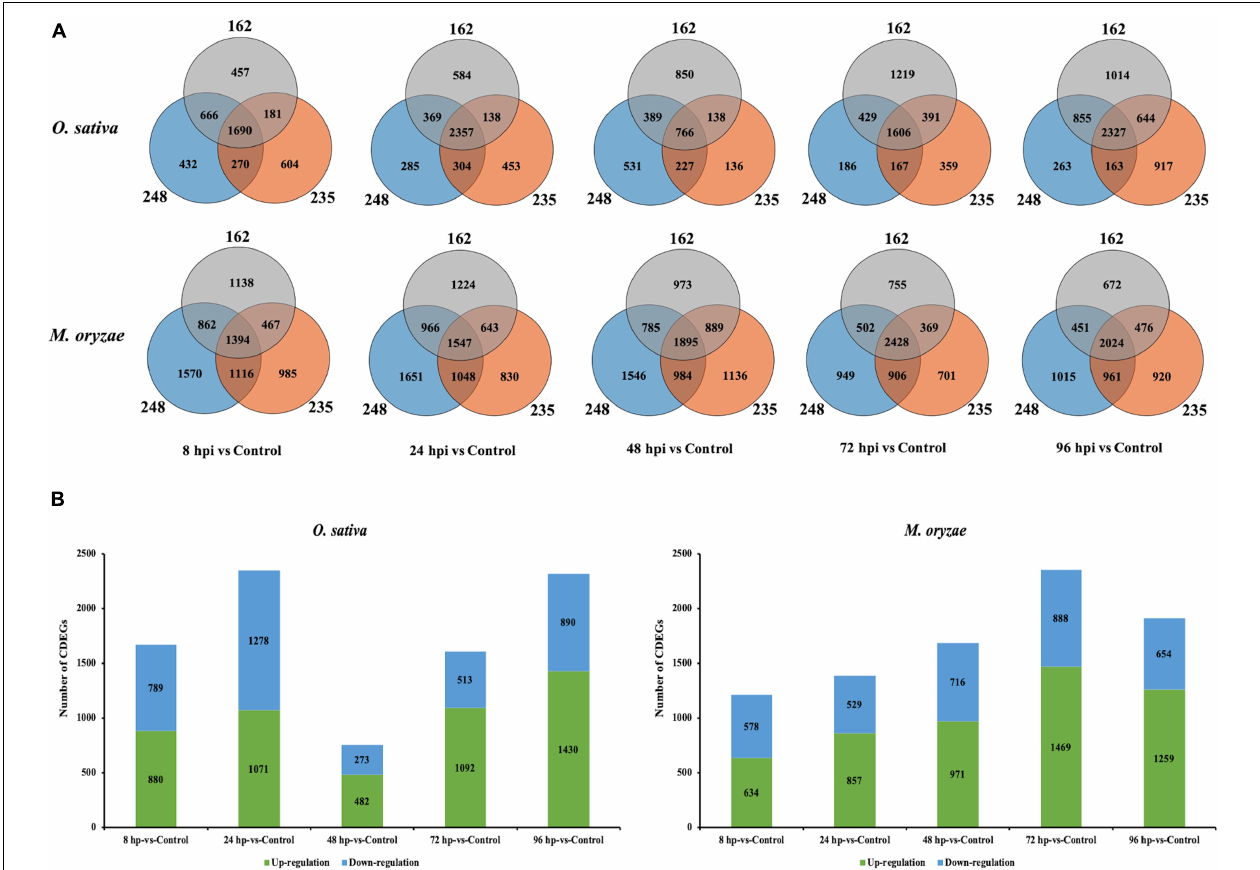
FIGURE 1 | Overview of differentially expressed genes (DEGs) identified in interactions between Nipponbare (Nip) and three strains of Magnaporthe oryzae (248, 235, and 162) at 8, 24, 48, 72, and 96 hpi. (A) Venn diagram displaying overlap between DEGs in interactions between Nipponbare (Nip) and three strains of M. oryzae . OS represent Oryzae sativa L. ssp. japonica cv. Nipponbare and MG represent Magnaporthe oryzae . (B) Expression regulation of conserved DEGs